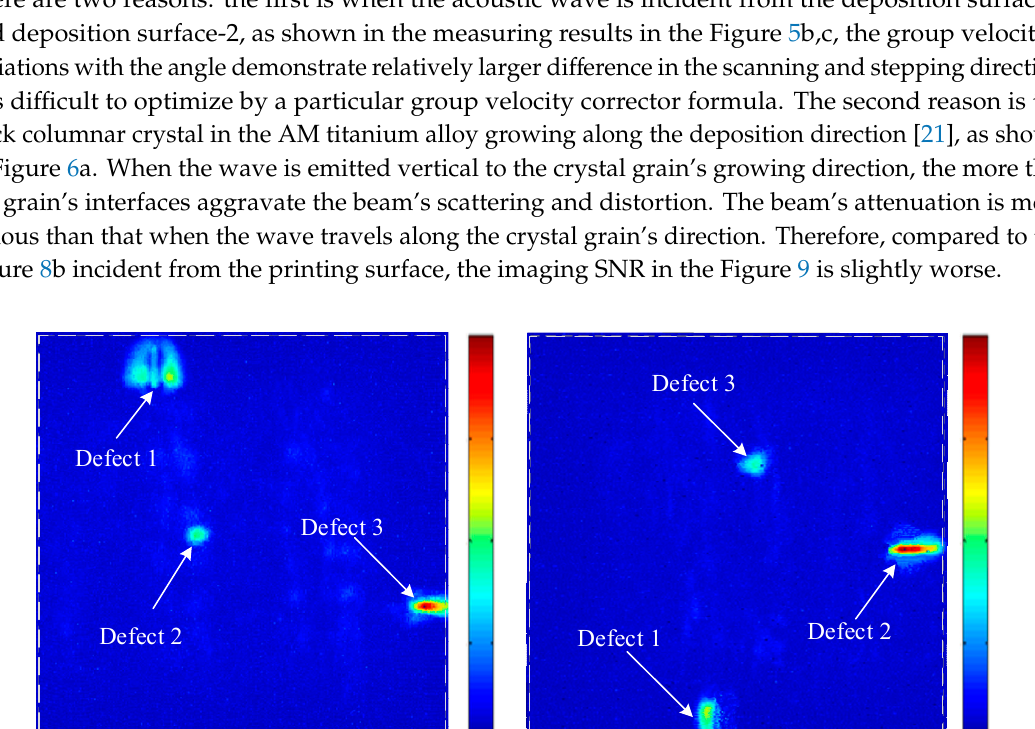
Figure 8. A comparison of linear array and annular array inspection results (the printing surface). ( a ) The linear array C-scan image using the conventional dynamic depth focusing (DDF) method. ( b ) The annular array C-scan image using the TFM.